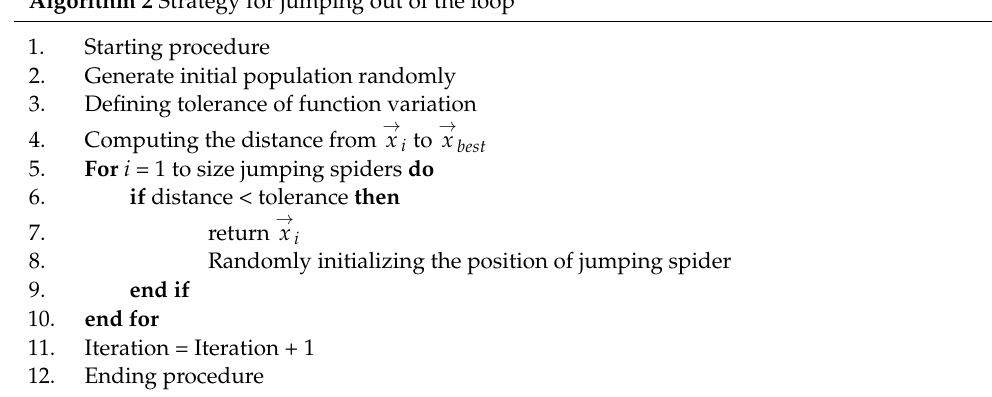
Algorithm 2 Strategy for jumping out of the